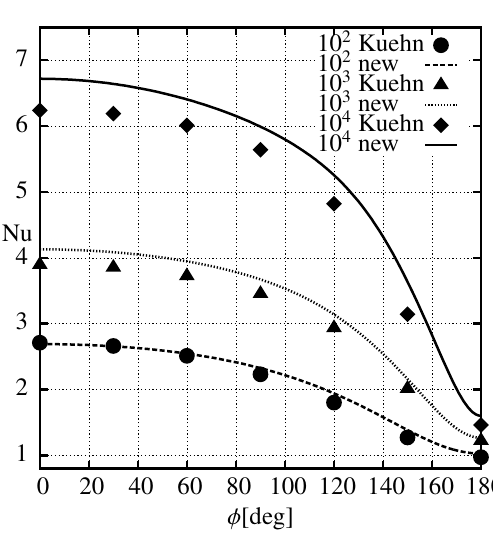
Fig. 6. Nusselt number distribution over cylinder in natural con- vection, comparison of data from [11] and the new scheme for Ra ∈ { 10 2 , 10 3 , 10 4 } . Angle φ is measured from the lowest point of the cylinder.